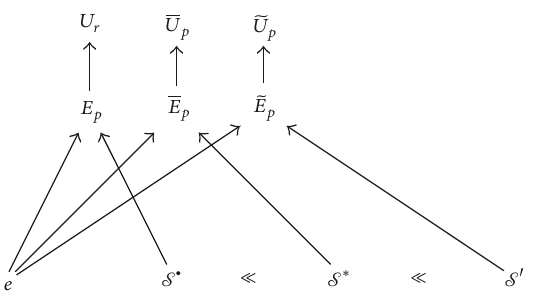
Figure 7: The causal structure for the three echoing systems E ch, E ch, and ̃ E ch with the event 𝑒 . The chronological order between S ∙ , S ∗ , and S 耠 belonging to W S can be different.